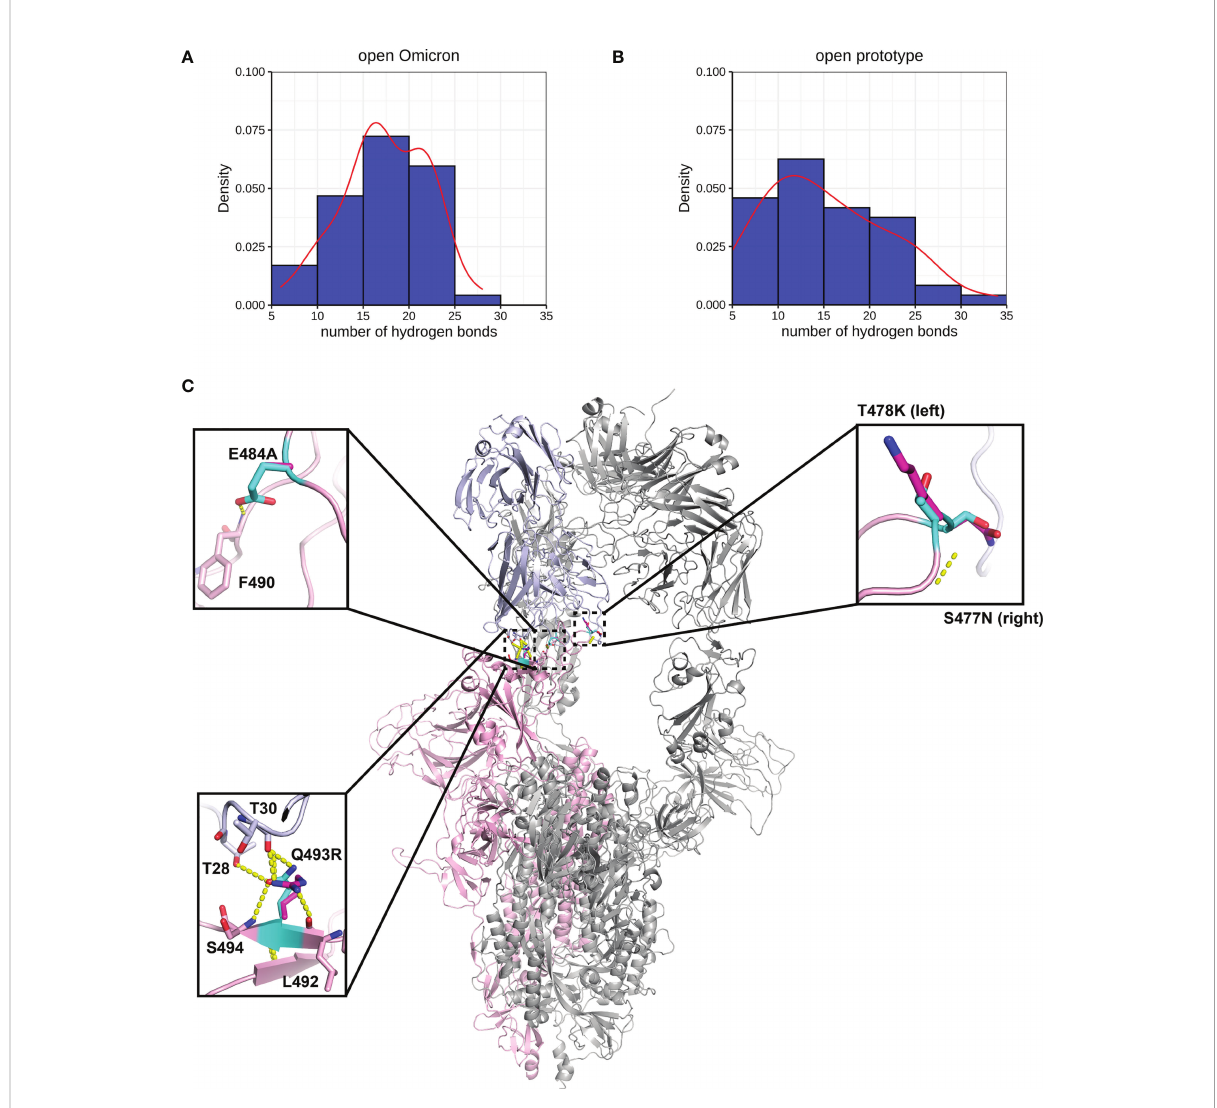
FIGURE 5 Interactions between Spike and antibody (P5A-2F11). Hydrogen bond interaction distribution between residues in Spike (residues 332-527) and antibody proteins during 20 ns of triplicate MD simulations in (A) Omicron and (B) prototype variants are shown in blue histogram with its smoothed density line shown in red. Both represent RBD-up conformation of Omicron and Prototype Spike proteins. Density on y axis refers to the Kernel density, the image depicts the probability density function of the variable The Spike protein was presented in ribbon with three RBD all binding to P5A-2F11 (C) . Both prototype (cyan) and Omicron residues (magenta) were shown in sticks with the Carbon atoms on Spike-P5A- 2F11 complex (pink-blue). Hydrogen bond was shown in yellow dash